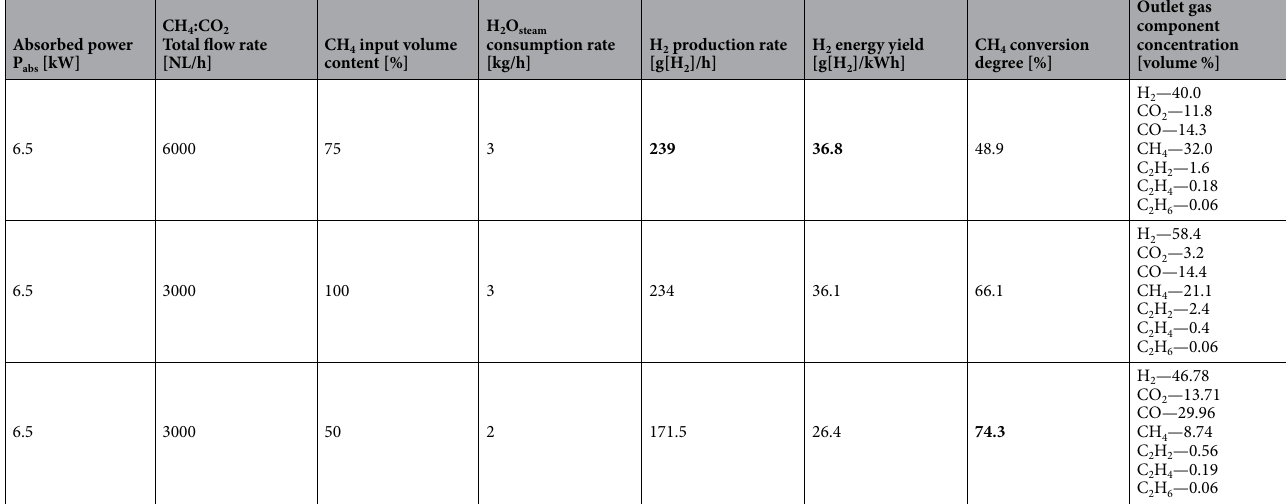
Table 1. Best results of the steam reforming in the presented 915 MHz MPS. Maximum values are in bold.